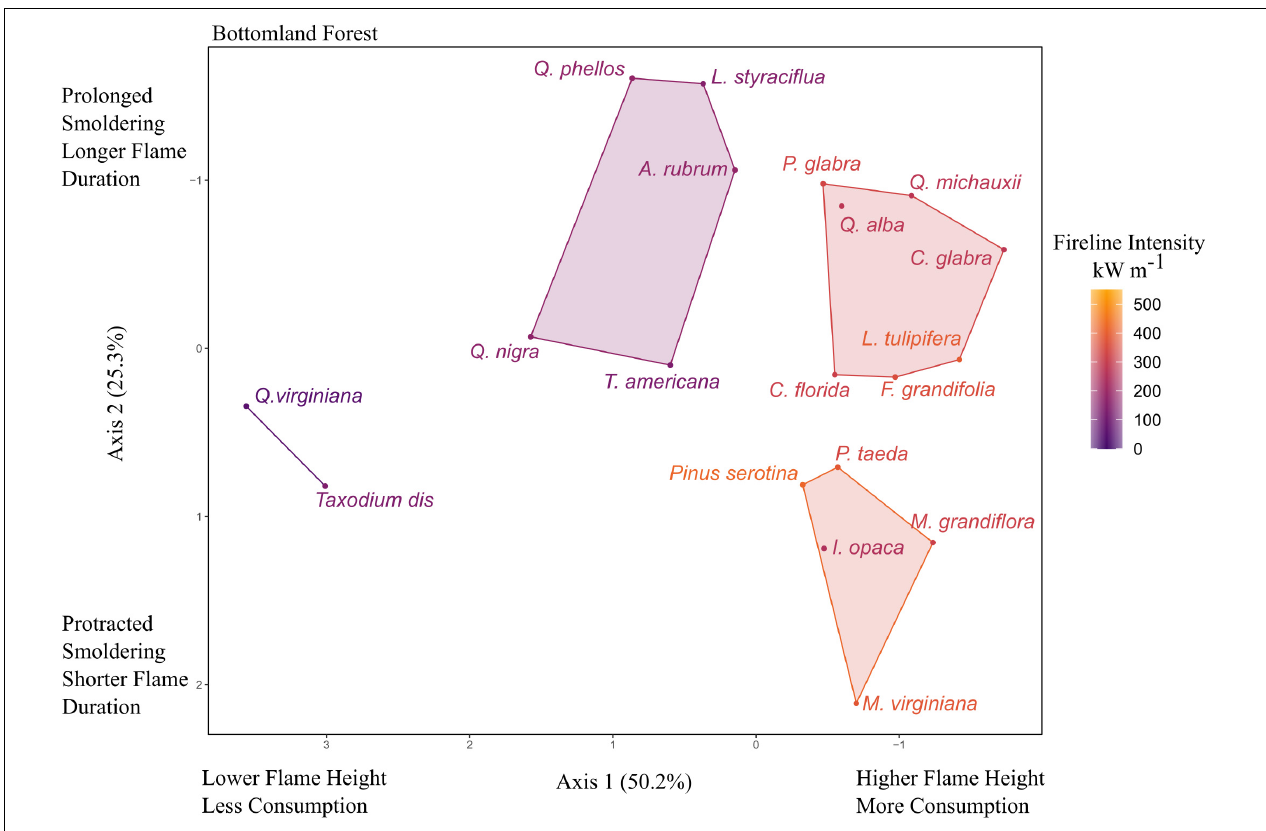
Table 1 and Supplementary Table 1